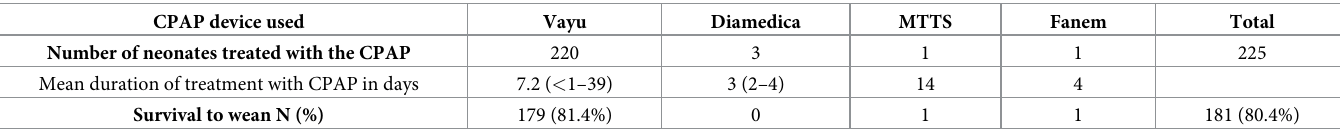
Table 2. Patient outcomes of neonates treated with bCPAP Systems in the Muhimbili National Hospital Newborn Unit between June 4, 2021 and October 10, 2021. CPAP device used Vayu Diamedica MTTS Fanem Total Number of neonates treated with the